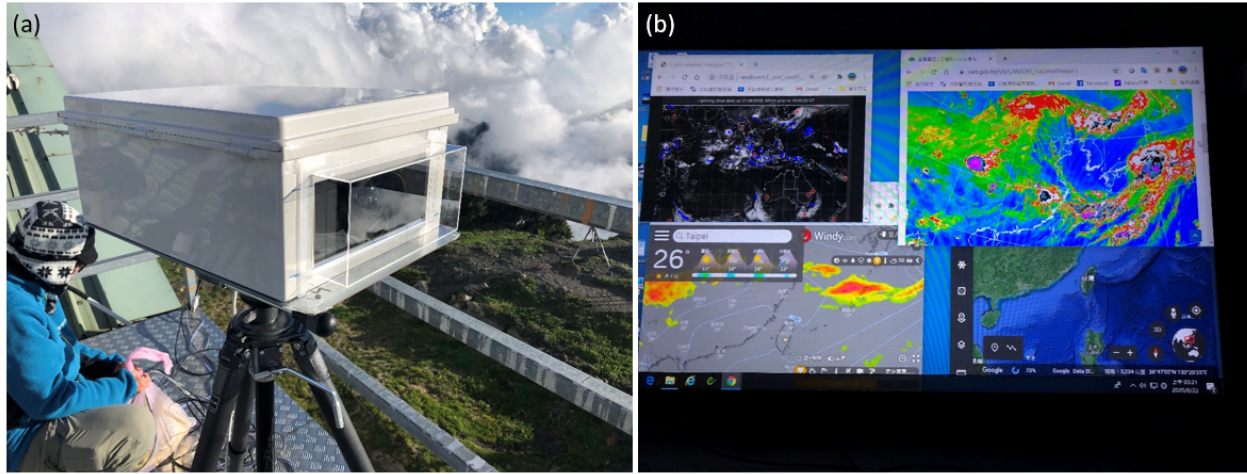
Figure 1. ( a ) The setup of our low-light-level CCD and high-speed-camera on the elevated work platform, and ( b ) the LCD monitor to show the near real-time of WWLLN lightning map, cloud top weather map and forecast of weather report in the observation room.